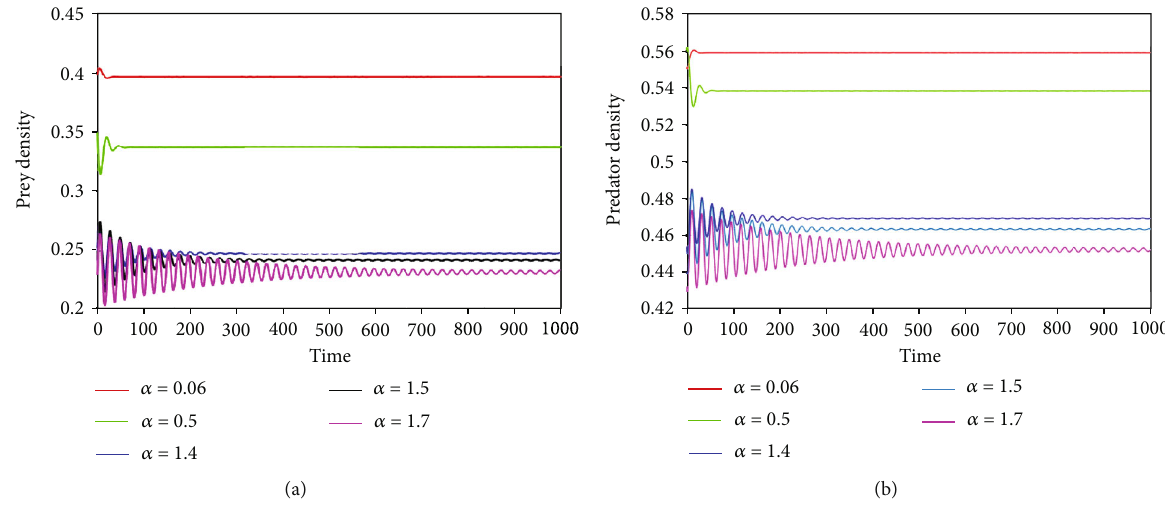
= 0 : 12, ð α = 0 : 06, 0 : 4, 1 : 4, 1 : 7 Þ , β = 0 : 2 Þ and 1